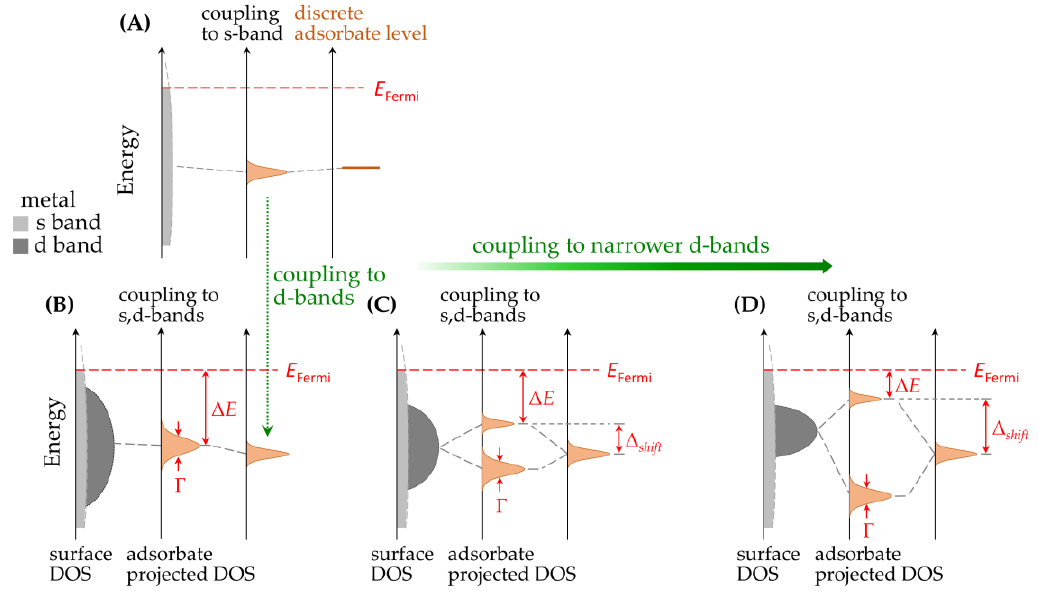
Figure 6. Proposed improvement of energy-level alignment ( ∆ E ) with narrow surface d-bands on a bimetallic surface. ( A ) The adsorbate state is broadened due to its interactions with the surface s-states. ( B – D ) The broadened state is ( B ) further broadened or ( C , D ) split into a bonding state and an anti-bonding state due to its interactions with the surface d-states. Whether it develops into band broadening or splitting depends on the distribution of surface d-states (or d-bands). Additionally, the narrower surface d-bands may drive a shift of the anti-bonding state closer to the Fermi level, resulting in a better degree of ELA. This figure is adopted from